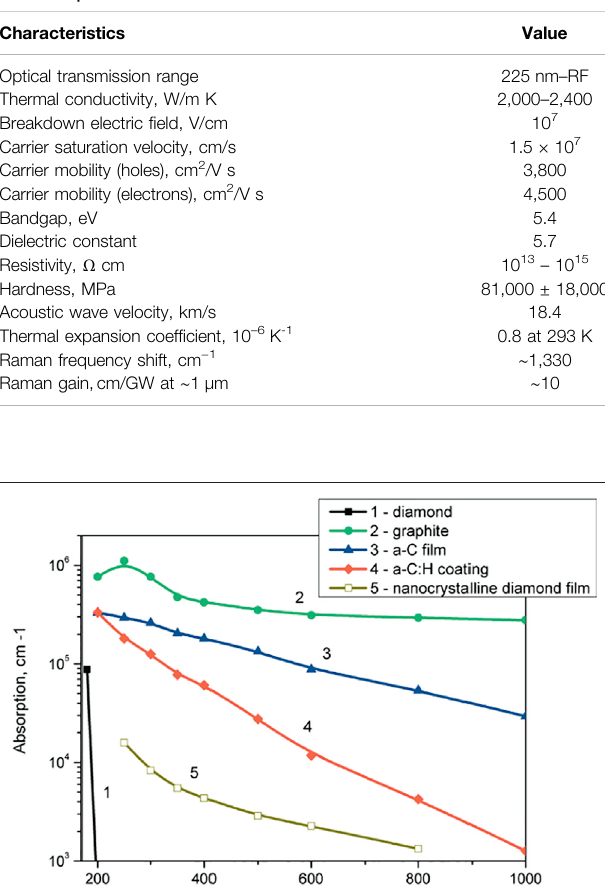
FIGURE 1 | Dependence of the optical absorption coef fi cient on the laser wavelength [6].